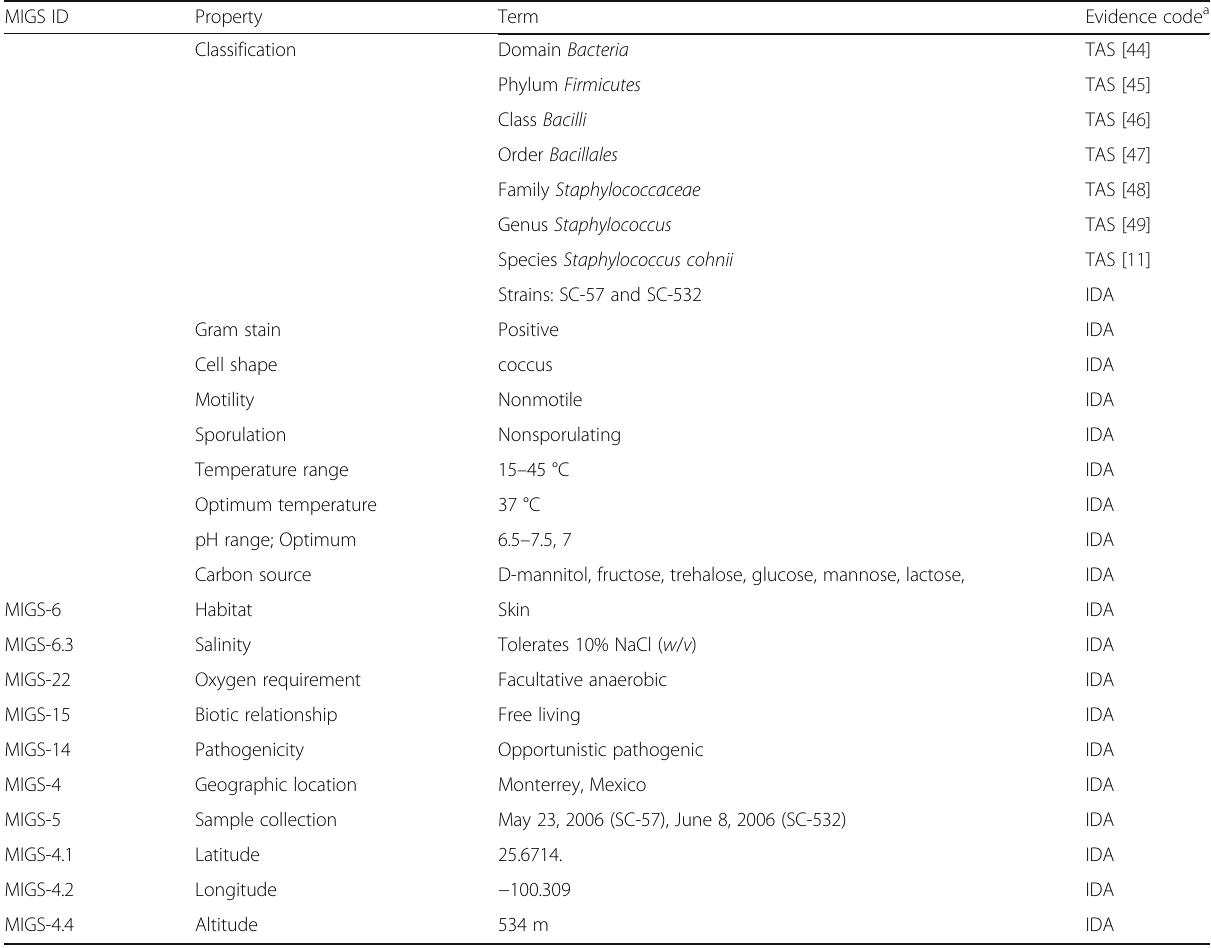
Table 1 Classification and general features of Staphylococcus cohnii strains SC-57 and SC-532 [10] MIGS